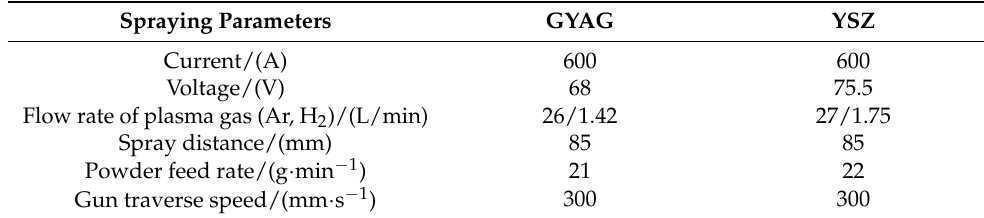
Table 3. Processing parameters for plasma-sprayed ceramic